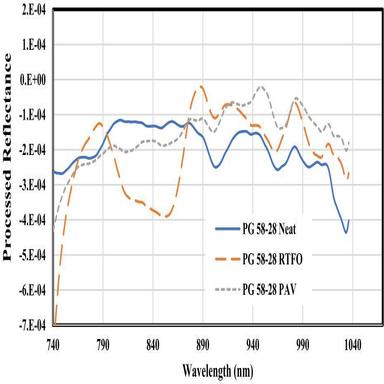
Comparison of the PG 58-28 binders with 5% rubber at different aging levels.